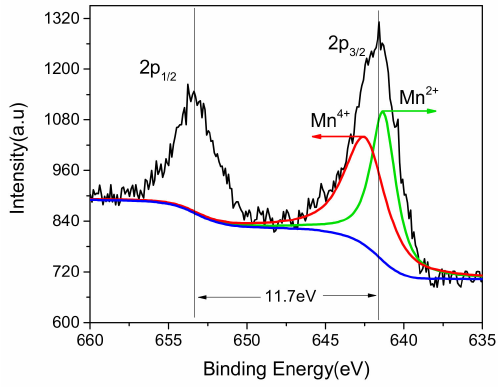
Figure 7. XPS spectrum of flocs collected from Mn(III) + C /